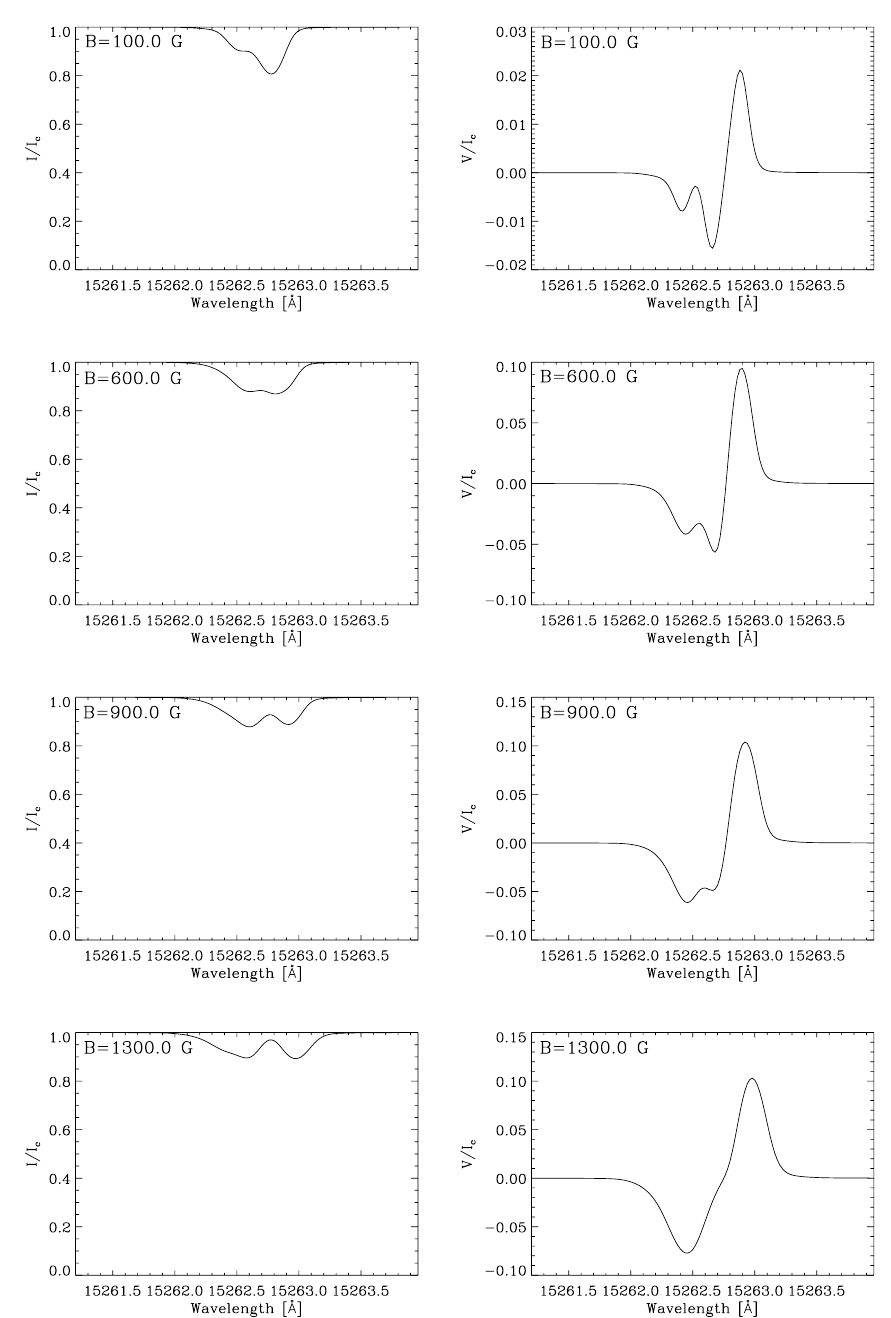
Figure 24: The Stokes profiles for the 1526 nm Mn i absorption line for various magnetic field strengths are shown in this figure. For magnetic fields less than about 1000 G, the two spectral components in the Mn i line show different strengths, and then for fields at higher values the spectral components more apart in wavelength. The special hyperfine structure involved in this line provides a uniquely sensitive measurement of the solar magnetic field. Image reproduced with permission from Asensio Ramos et al. (2007), copyright by